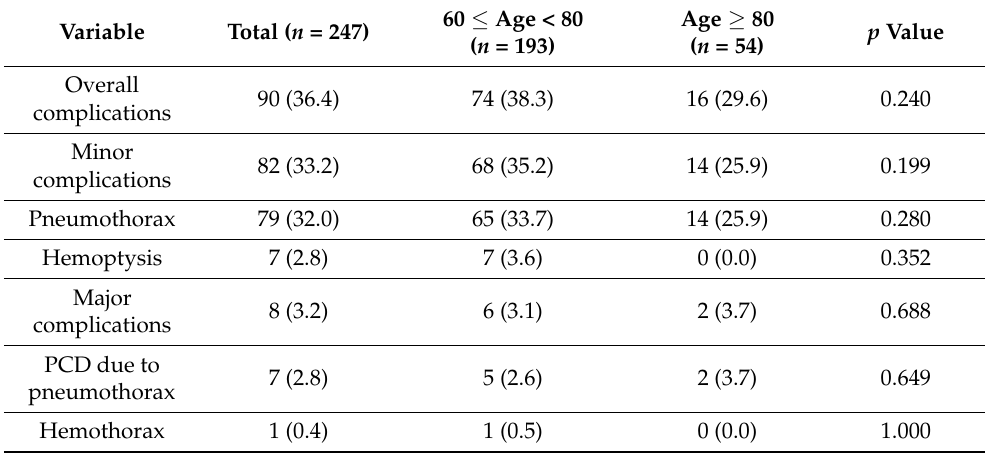
Table 4. Complications of CT-guided PTNB in the study